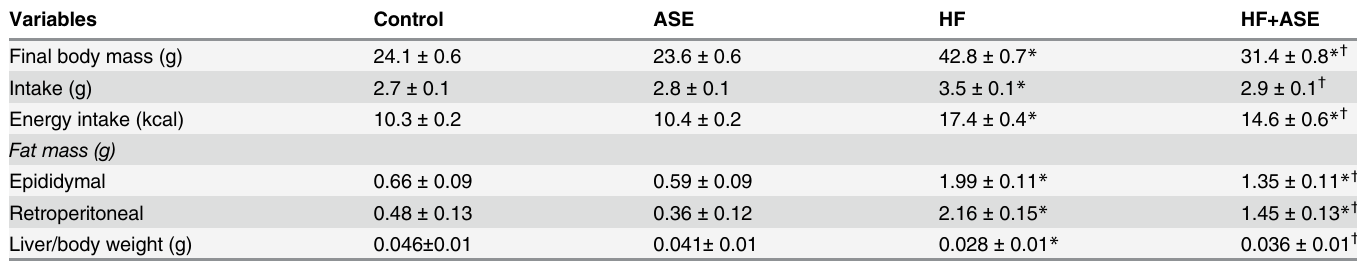
Table 2. Effects of HF diet and ASE on body mass, food intake, energy intake, visceral adipose mass and liver parameters of C57BL/6 mice